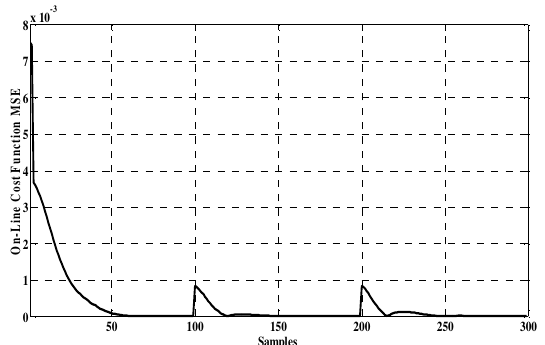
Fig. 7. On-line performance index (MSE).